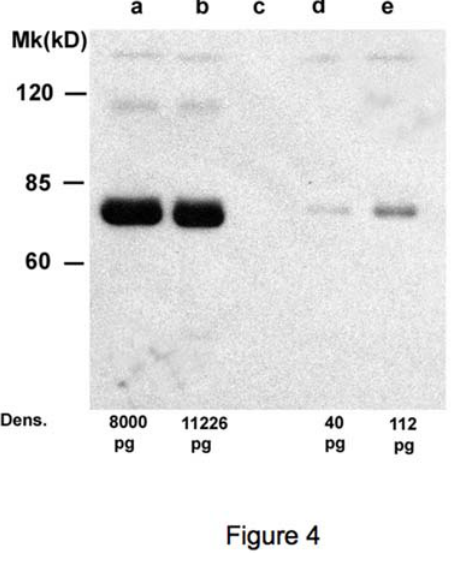
Figure 4. sICAM-1 levels in culture supernatants from imma- ture (a) and mature oocytes (b). Immature oocytes were analysed individually for morphological characteristics to differentiate them as Metaphase I (MI), germinal vescicle (GV) and degenerated (DEG). (a). Mature oocytes were subdivided on the basis of the first polar body and cytoplasm characteristic in Grade 1, 2 and 3 (b). Preparation of oocyte supernatants was performed as described in the legend to Figure 2. * Student t Test.